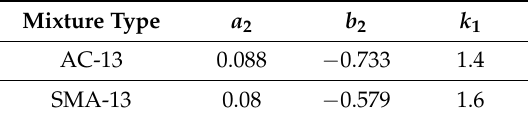
Table 6. Parameters of the linear failure